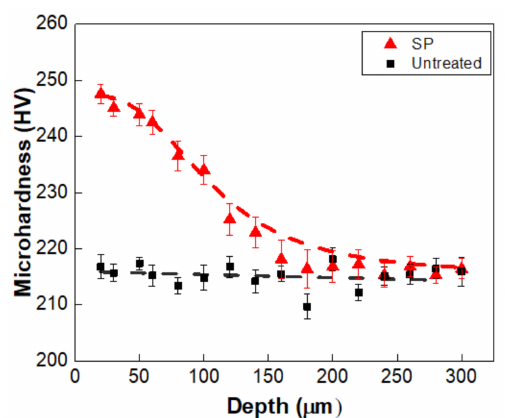
Figure 3. Microhardness of T91 untreated (black squares) and shot peened (red triangles)